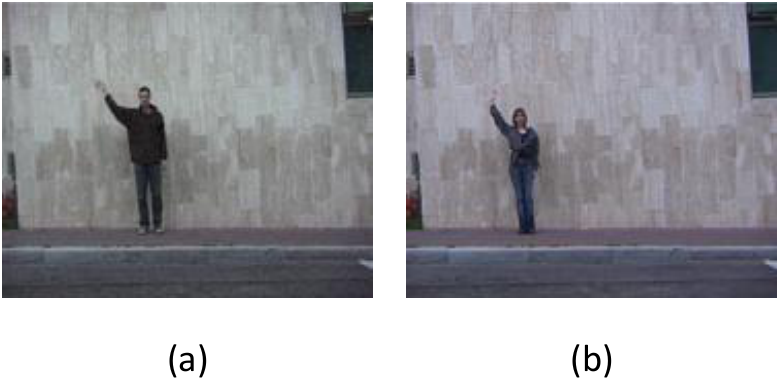
Figure 7. Abnormal “SHSW” actions. ( a ) Misclassification example; ( b ) Un-Classification example.